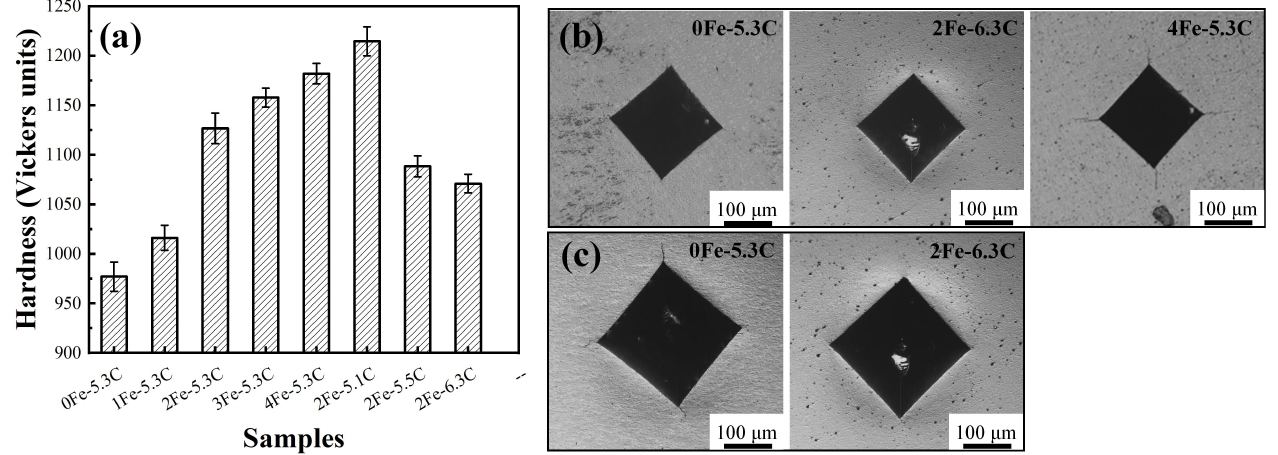
Figure 13. The hardness ( a ) and the micrographs of Vickers’ indentations and induced surface cracking in different WC–Co–Fe samples under 30 kg ( b ) and 50 kg ( c ) pressure,